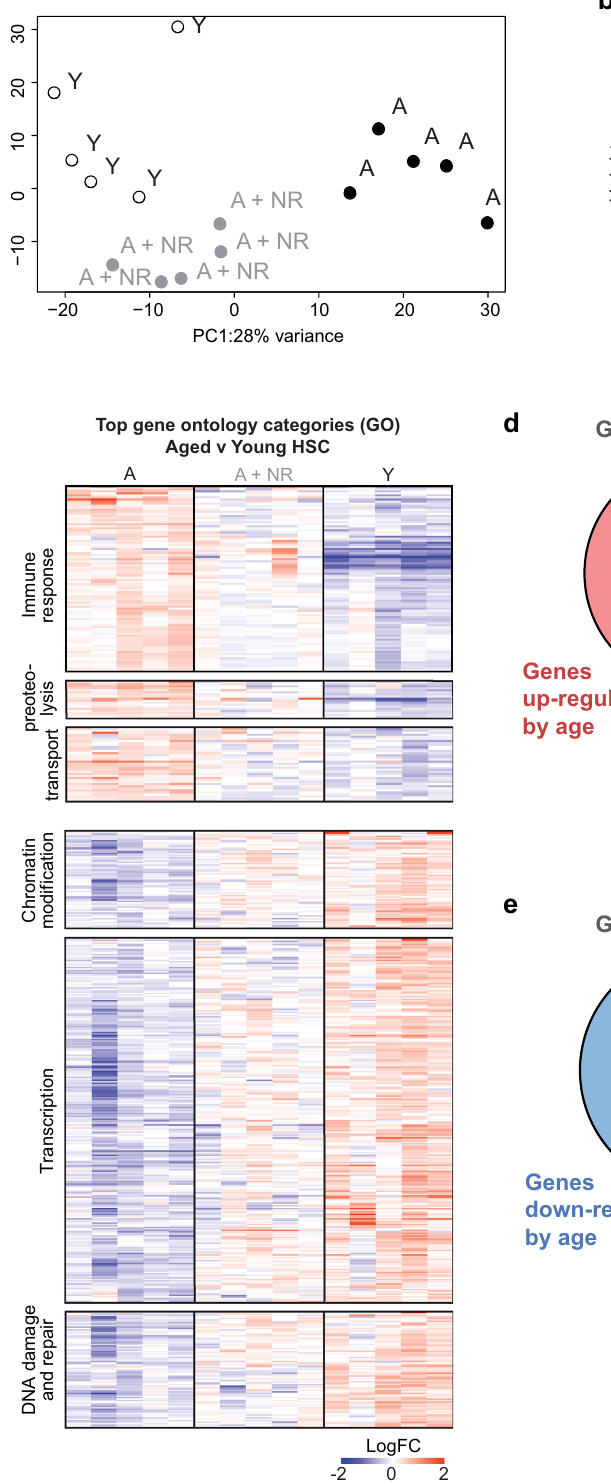
(Fig. 4a, b). Strikingly, NR administration in aged mice signi fi cantly reduced the capacity for basal respiration and ATP production in aged stem and progenitors (HSPC) to levels indistinguishable from young (Fig. 4a, b). Conversely, NR administration in young mice only mildly (but signi fi cantly) reduced HSPC capacity for basal respiration and ATP production (Supplementary Fig. 5b, c), consistent with previous fi ndings 34